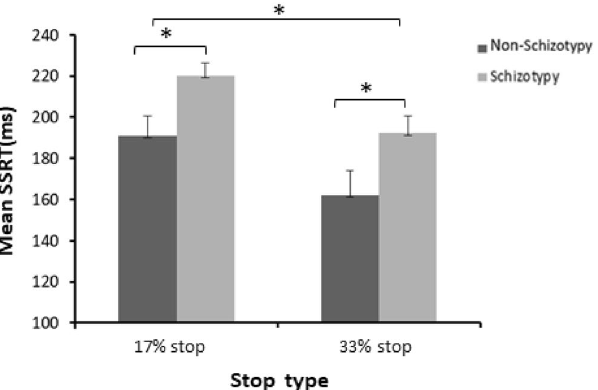
Figure 2. Stop-signal reaction time (SSRT) of “17% stop” trials and “33% stop” trials for the non-schizotypy and schizotypy group. Error bars represent standard error. * p <